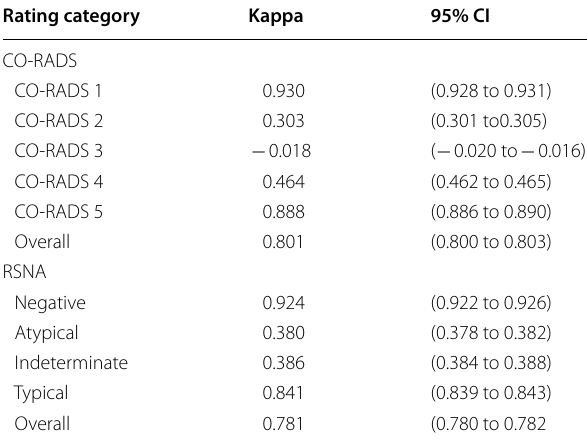
Table 6 Inter‑reviewer agreement for CO‑RADS and the RSNA chest CT classification system stratified according to different categories